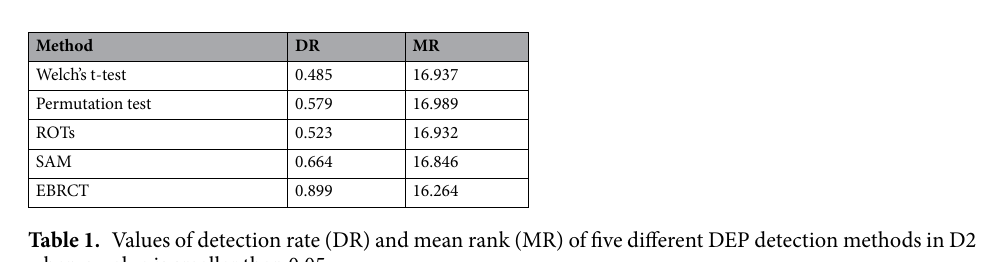
Figure 2. ROC curves of five different DEP detection methods using D1. The pAUC values were listed on the right bottom of this